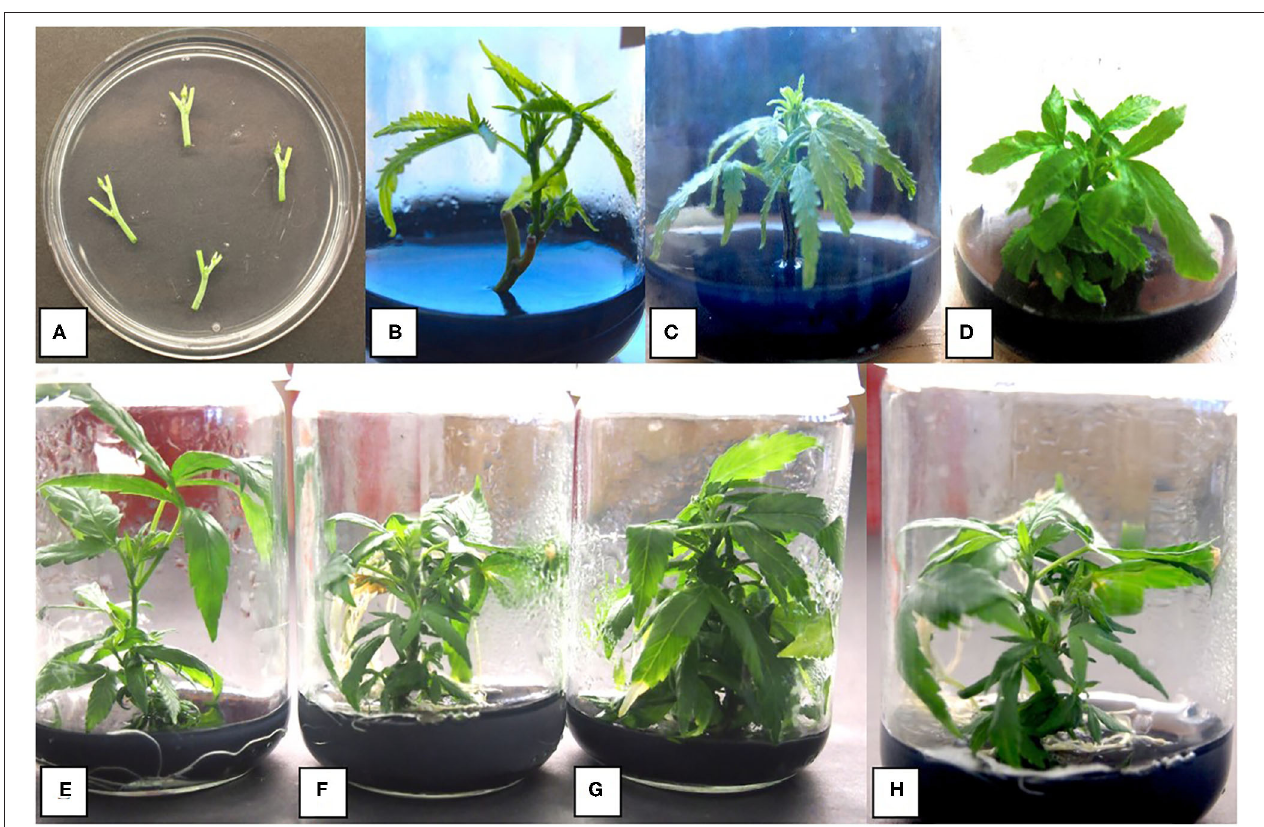
FIGURE 2 | Stages of growth of shoots derived from nodal segments of drug-type cannabis genotypes grown on MM containing activated charcoal. (A) Nodal stem explants placed on an agar medium in a 90-mm Petri dish to show their size. (B) Shoot growth after 4 weeks from a nodal stem explant. The rate of growth is greater than that from a meristem. (C) Shoot growth after 6 weeks. (D) Shoot growth after 8 weeks. (E) Shoot growth after 8 weeks of genotype Death Bubba (DEB) from nodal explants. (F) Shoot growth after 8 weeks of genotype Pink Kush (PNK) from nodal explants. (G) Shoot growth after 8 weeks of genotype White Rhino (WHR) from nodal explants. (H) Shoot growth after 8 weeks of genotype Moby Dick (MBD) from nodal